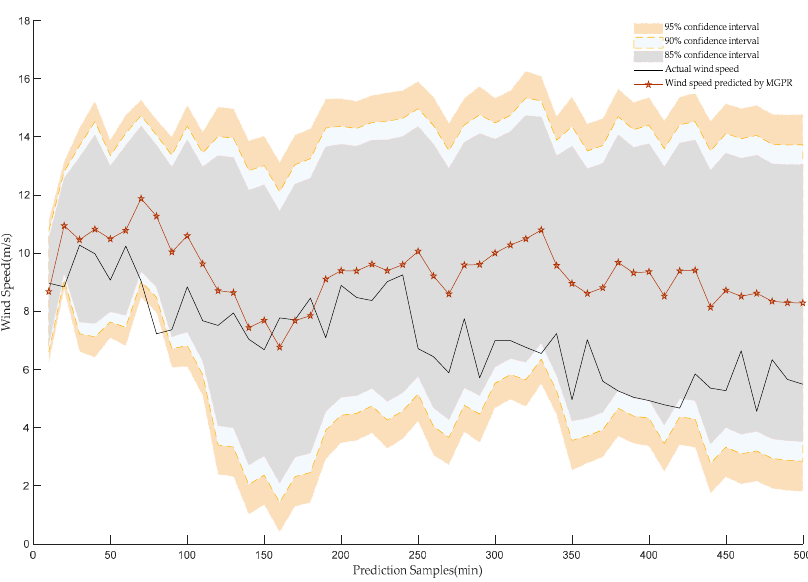
Figure 17. Interval and point prediction results of mixture Gaussian process regression (MGPR).